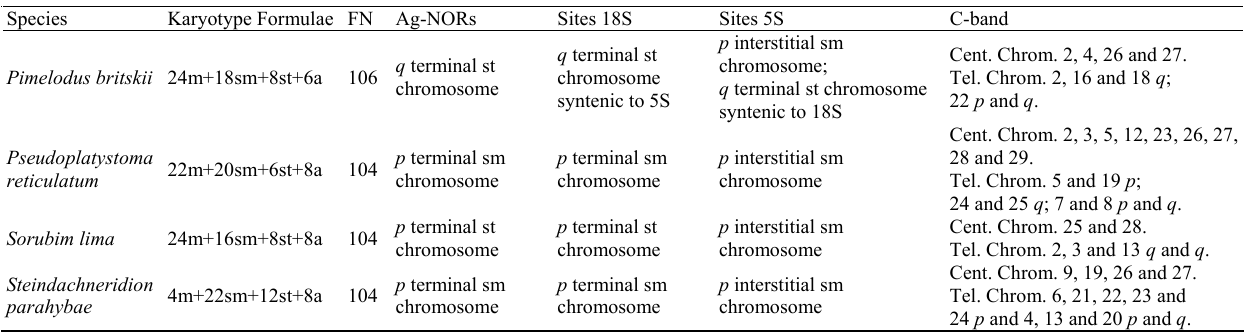
Table 1. Karyotype characteristics of the species studied. FN = fundamental number (number of chromosome arms); Ag-NORs = tagging of nucleolar organizing regions by silver colloidal; 18S sites = localization of 18S rDNA probe; 5S sites = localization of 5S rDNA probe; C-band = chromosomal localization of heterochromatin; m = metacentric chromosome; sm = submetacentric chromosome; st = subtelocentric chromosome; a = acrocentric chromosome p = short arm; q = long arm; Cent. Chrom. = centromere of chromosomes; Tel. Chrom. = telomere of